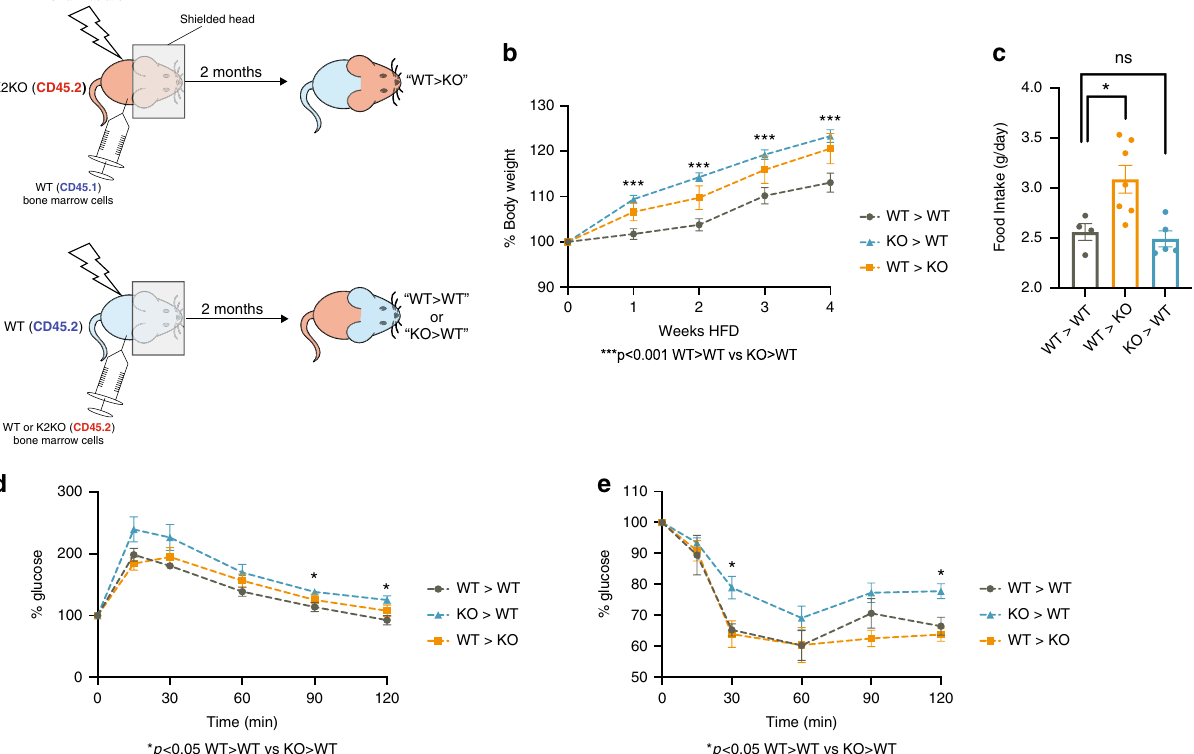
Fig. 5 Deletion of KLF2 con fi ned to peripheral myeloid cells contributes to metabolic disease. a Schematic depiction of bone marrow transplant protocol and resultant chimeras created. b Chimeras with preserved WT microglia but K2KO hematopoietic myeloid cells (KO>WT) demonstrate elevated body weight gain on 4 weeks HFD, WT>WT n = 9, WT>KO n = 10, KO>WT n = 13, p = 0.0002 (1 week), <0.0001 (2 weeks), 0.0020 (3 weeks), 0.0028 (4 weeks) comparing WT>WT to KO>WT. c Chimeras with preserved KO microglia but WT hematopoietic myeloid cells (WT>KO) demonstrate elevated food intake across one month HFD, WT>WT n = 4, WT>KO n = 7, KO>WT n = 5, p = 0.0251. ( d ) KO > WT mice have slightly worse glucose intolerance on GTT, n = 5 ( p = 0.0202 at 90 min, 0.0109 at 120 min) and ( e ) worse insulin sensitivity on ITT, n = 5, p = 0.0111 (15 min) and 0.0177 (120 min) by unpaired, two-tailed Student ’ s t -test, comparisons marked or indicated in fi gure. Error bars represent SEM. n represents biologically independent mice throughout entire fi gure. Source data are provided as a Source Data fi